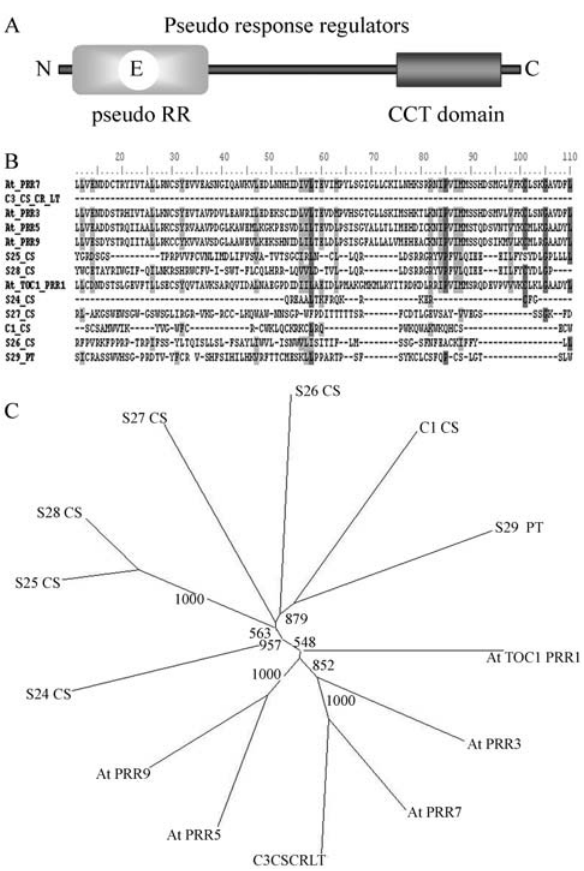
Figure 4 - Pseudo response regulator family of circadian clock compo- nents in citrus. A. Schematic representation of the domain structure of PRR proteins lacking the invariant phospho-accepting asparagine (re- placed by a glutamate residue). B. Amino acid alignment of the pseudo-response regulator domain of circadian clock PRR proteins. C. Phylogenetic analysis of citrus and A. thaliana PRR family. Neigh- bor-joining unrooted tree for citrus deduced amino acid and Arabidopsis full length sequences were aligned with ClustalX. Bootstrap values are in- dicated inside each branch. At, Arabidopsis thaliana ; C Number, contig number; S Number, singlet number; CS, Citrus sinensis ; CR, Citrus reticulata ; LT, Citrus latifolia , PT, Poncirus trifoliata .